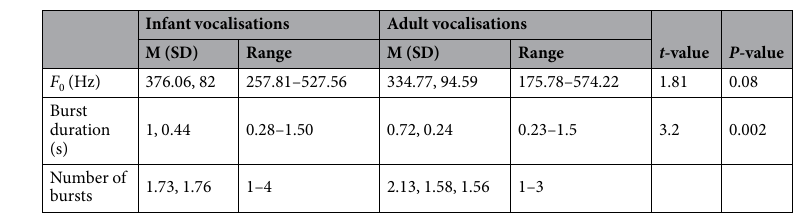
Table 2. Physical parameters of vocalization stimuli. F 0 , fundamental frequency. fMRI scanning and